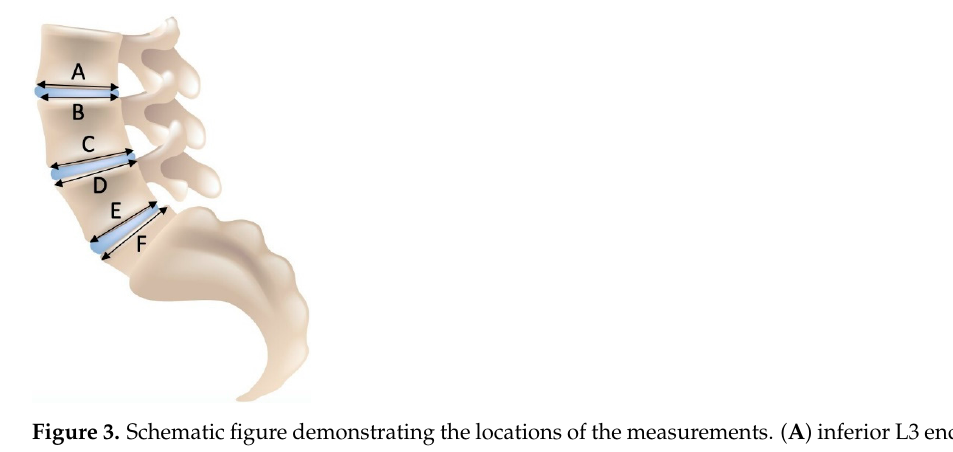
Figure 2. Difference in AP length in scalloping vertebrae .